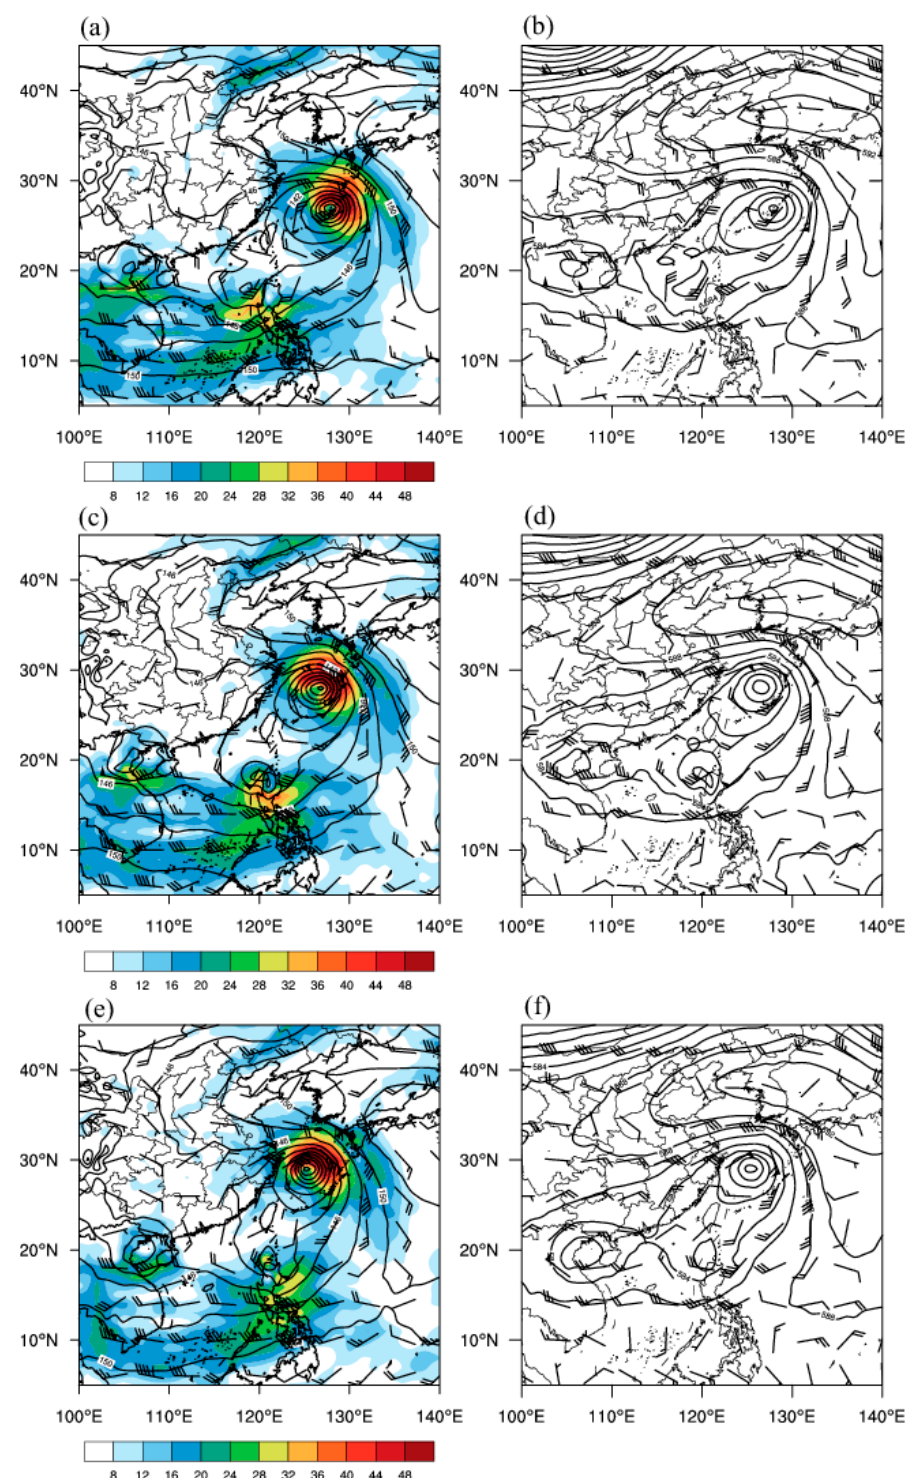
Figure 1. ( a , c , e ) The 850 hPa circulation including geopotential height (lines, unit: dagpm), specific humidity (shading, unit: g/kg), wind field (vectors, unit: m/s) and ( b , d , f ) the 500 hPa circulation including geopotential height (lines, unit: dagpm), wind field (vectors, unit: m/s) at ( a , b ) 0000 UTC, ( c , d ) 0600 UTC, ( e , f ) 1200 UTC on 21 July 2018. gpm is the units of geopotential height. 1 gpm = 9.8 J and 1 dagpm = 10